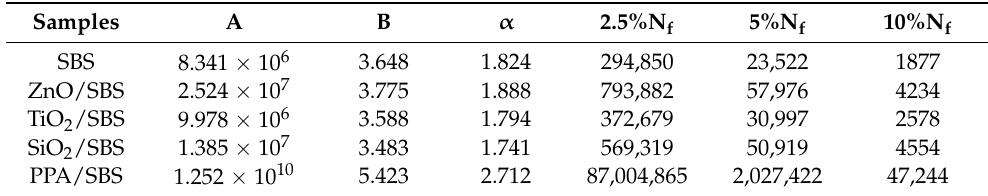
Table 3. LAS test results of different asphalts after long-term